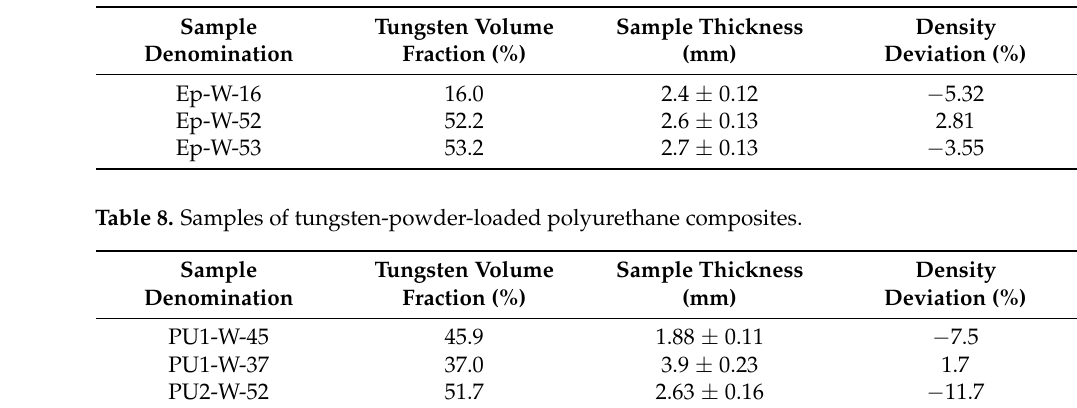
Table 7. Samples of tungsten-loaded epoxy resin composites.